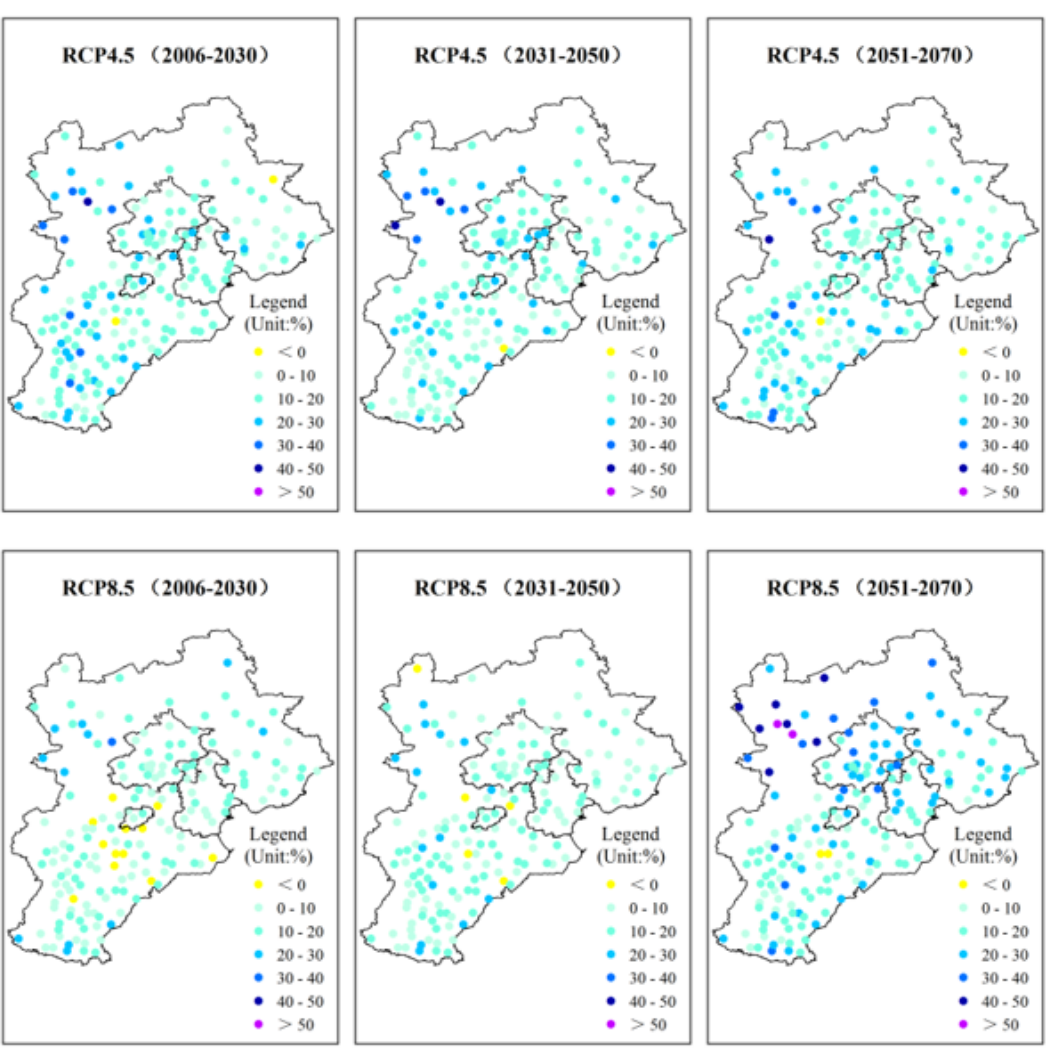
Figure 4. Spatial distribution of annual percentage changes of Exc25 across the Beijing-Tianjin-Hebei region during 2006–2030, 2031–2050 and 2051–2070, compared with 1961 – 2005.